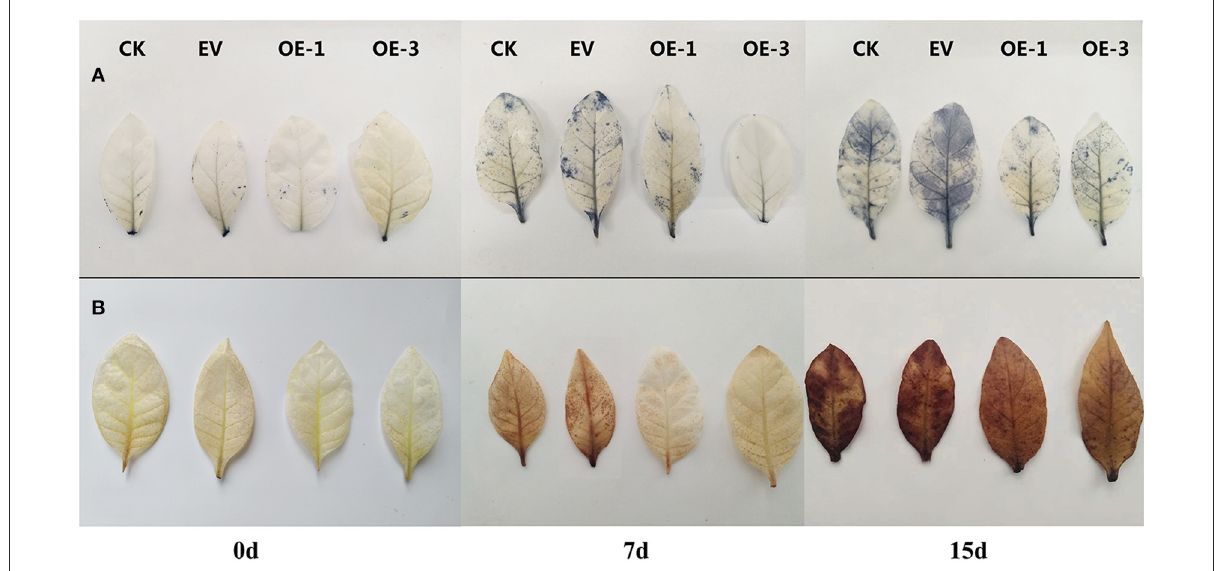
FIGURE6 Histochemical staining of the leaves of the transgenic tobacco lines overexpressing LpNAC17 under salt stress. Accumulation of (A) O 2 − and (B)